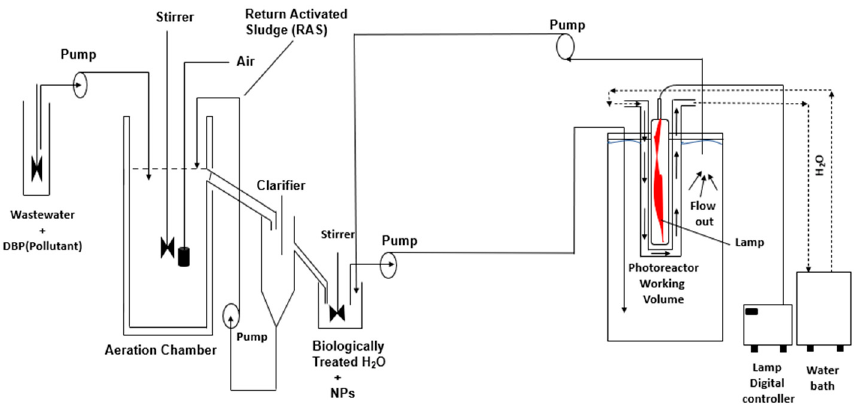
Figure 11. Simulated wastewater treatment plant.